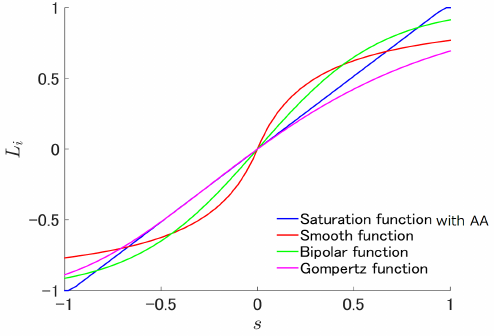
Figure 8. Candidate functions on wet asphalt simulation